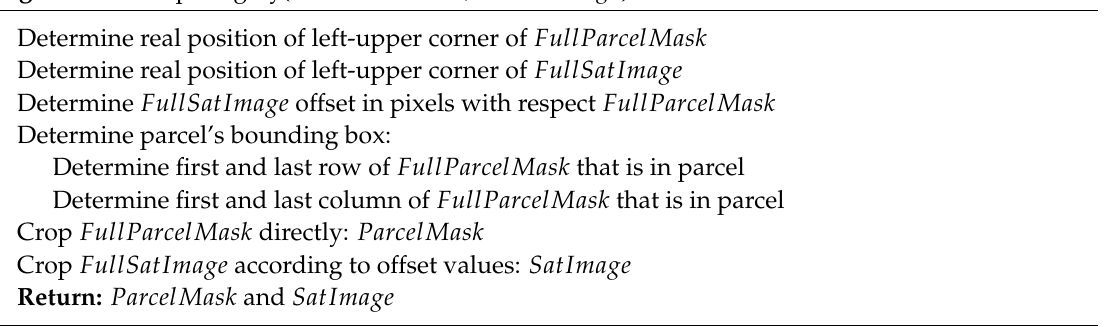
Algorithm 4 CropImagery{ FullParcelMask , FullSatImage }